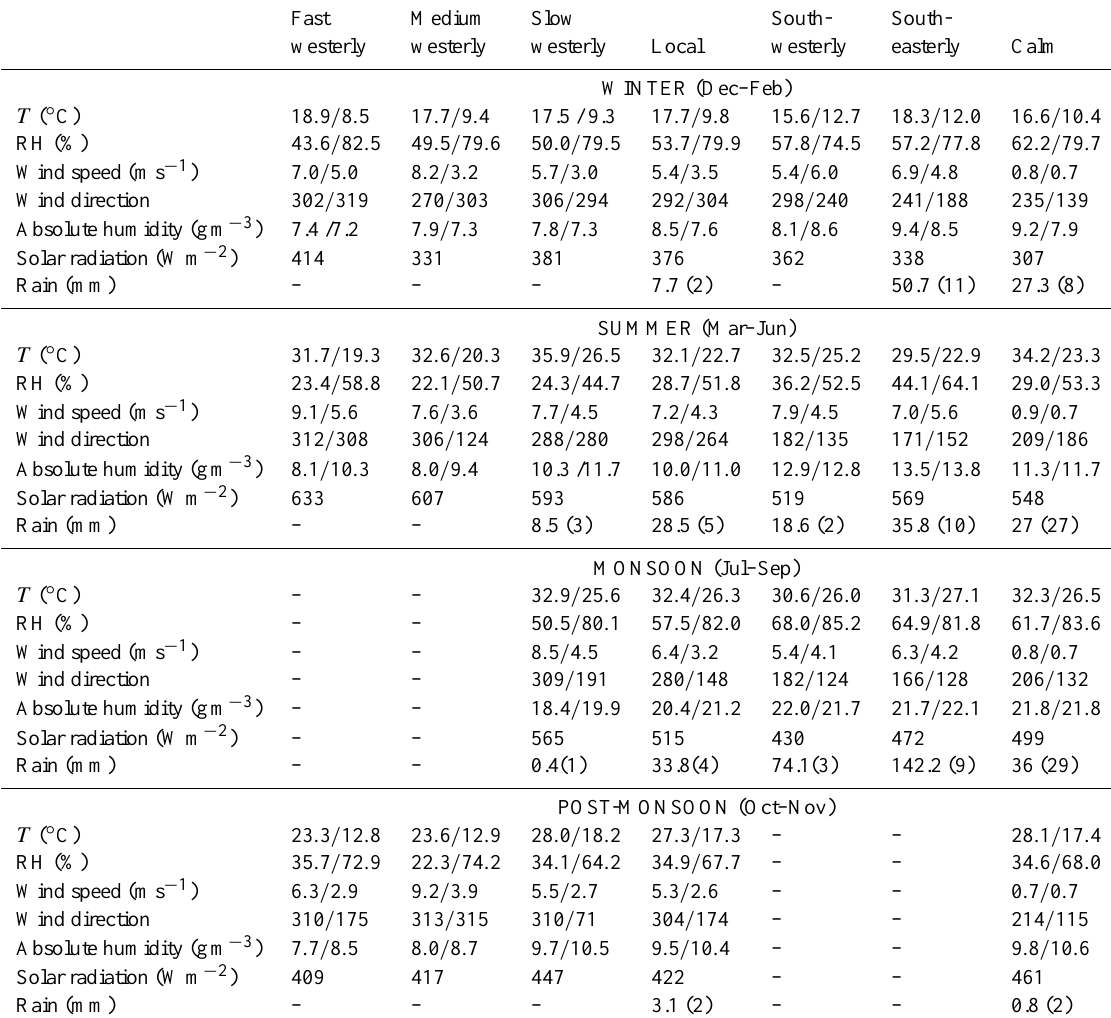
Table 1. Average of the locally measured meteorological parameters for daytime/nighttime for the different clusters and seasons. For solar radiation we provided the daytime average only. For rain we calculated the sum of the rainfall instead of the average and the numbers in brackets represent the number of rain